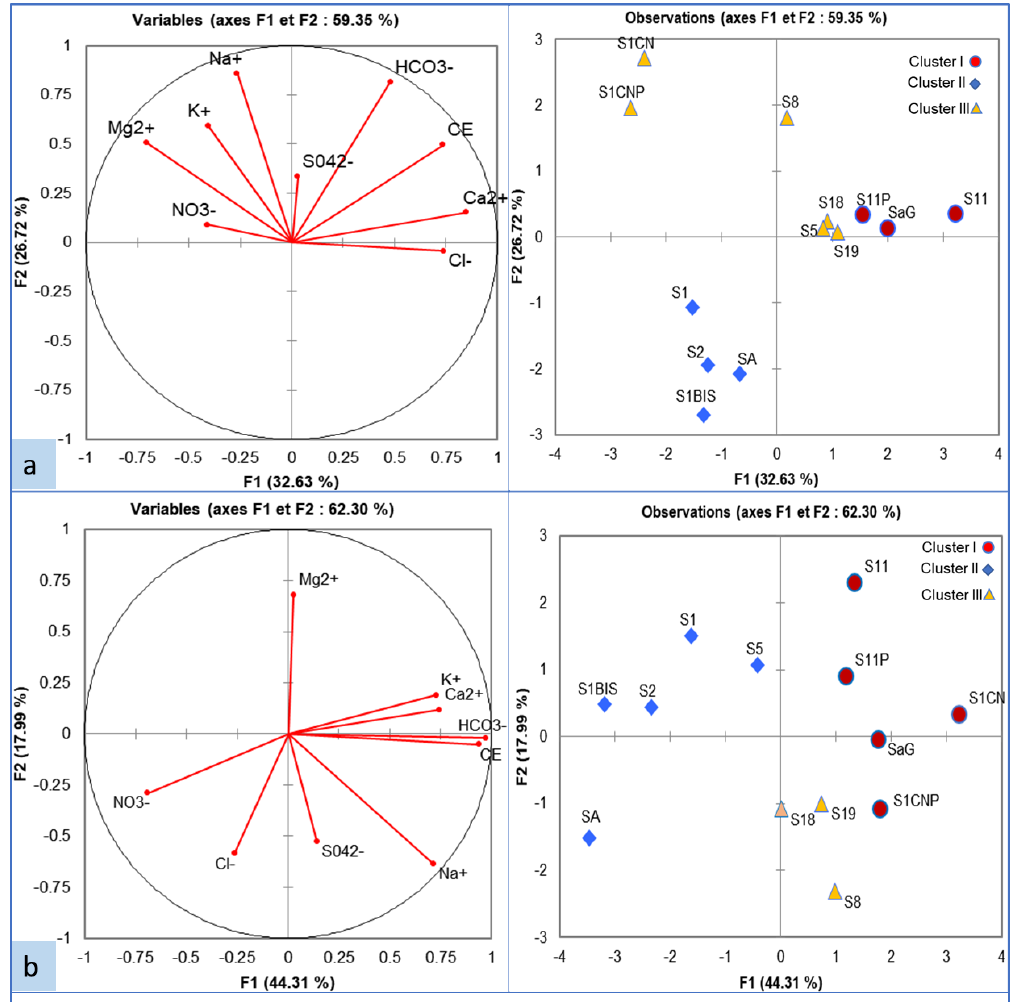
Figure 11. Principal component analysis (PCA) of groundwater: ( a ) low water and ( b ) high water; on the left, the projection of variables on the F1 – F2 plane; on the right, the projection of individuals on the F1 – F2 plane.